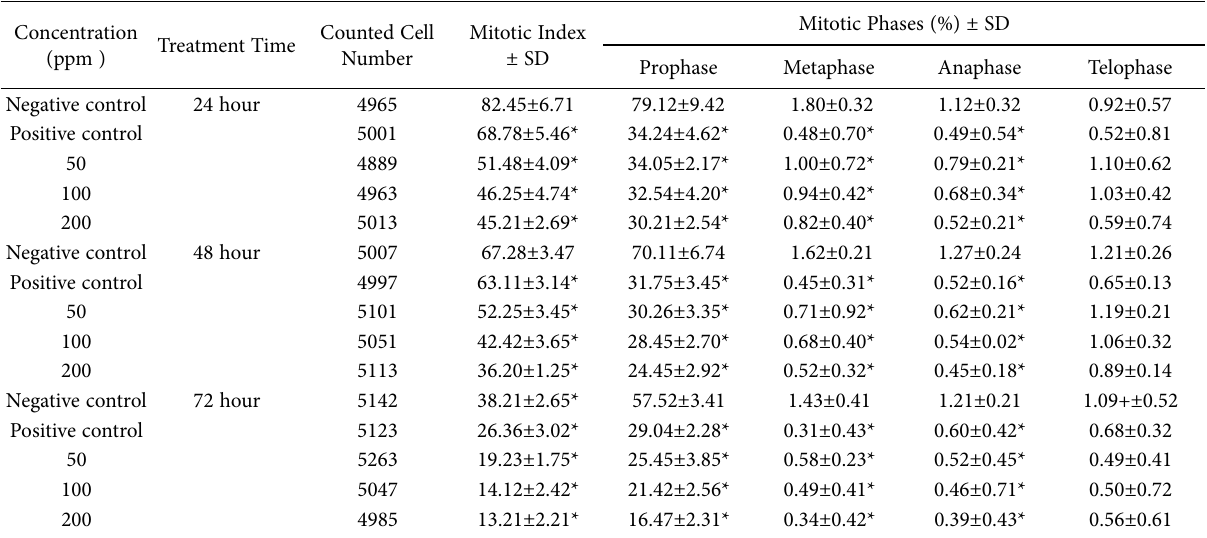
Table 2. The effects of Demond EC25 on MI and mitotic phases in the root cells of A. cepa.